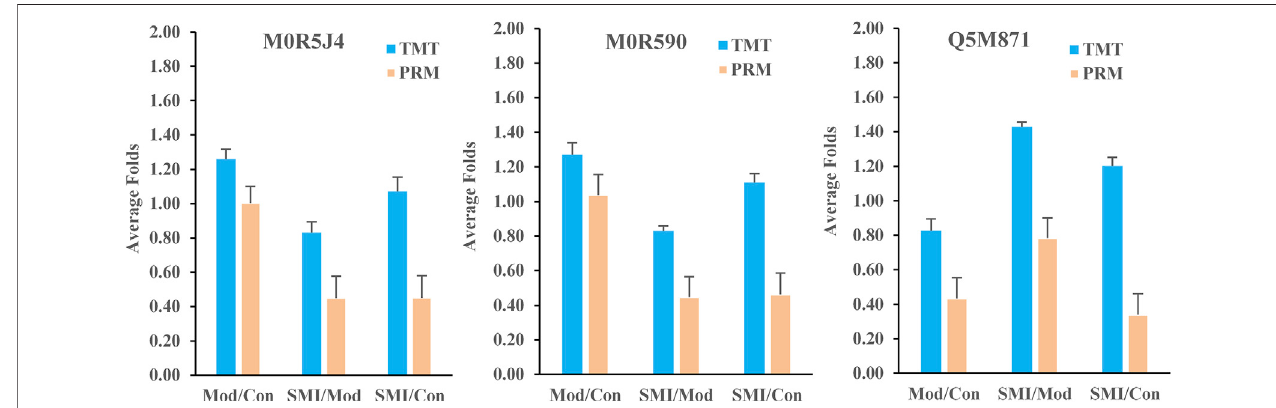
FIGURE 8 | Average protein relative expression folds of the three proteins (M0R5J4, M0R590, and Q5M871) in Mod: Con, SMI: Mod, and SMI: Con by TMT and PRM, respectively. n (cid:1) 3 samples for each group (3 data points for each bar), each consisting of serum of three rats.